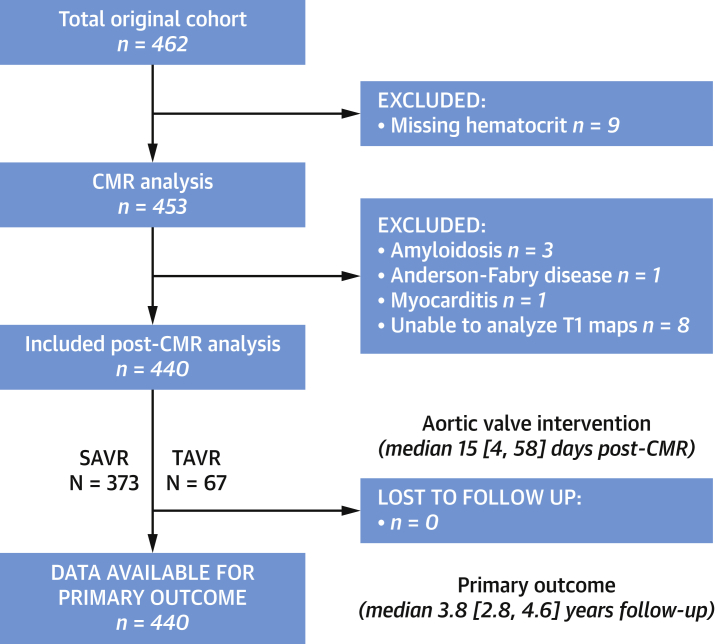
Flow Diagram of Study ParticipantsCMR = cardiovascular magnetic resonance; SAVR = surgical aortic valve replacement; TAVR = transcatheter aortic valve replacement.